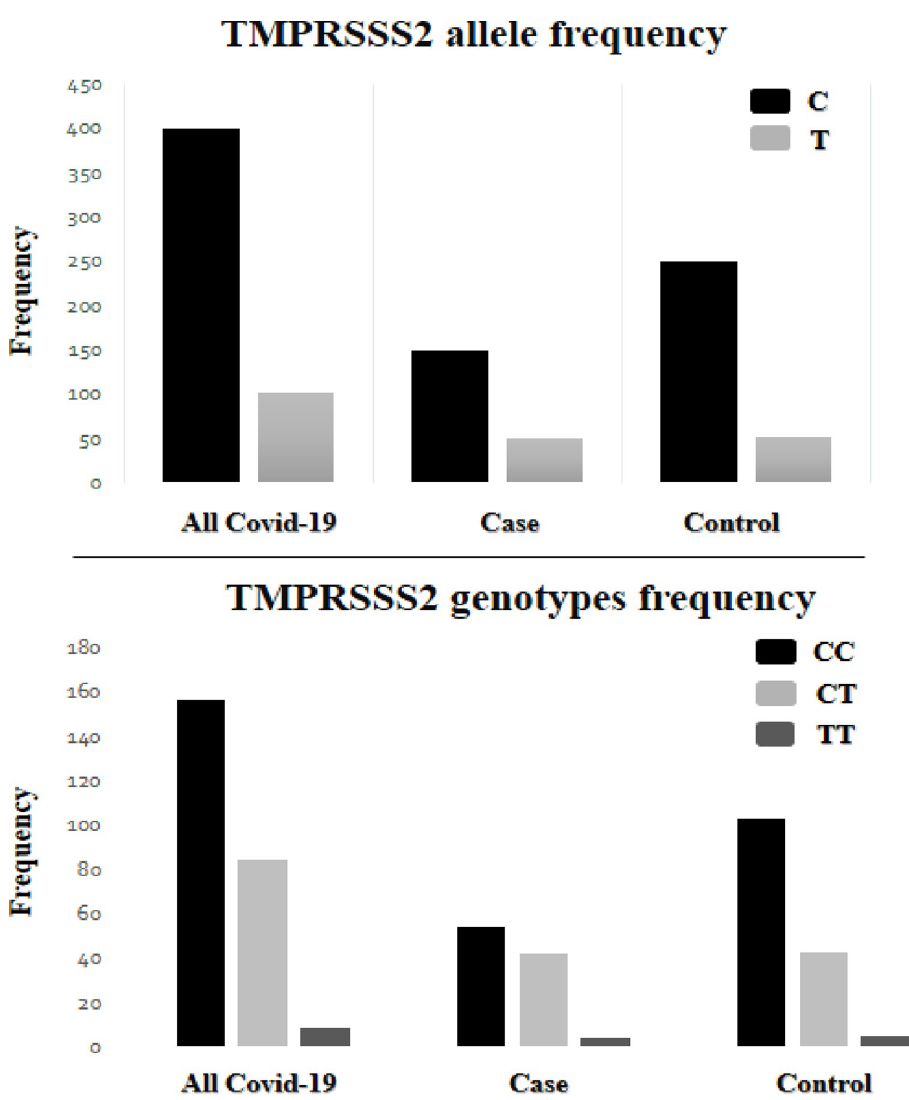
Fig 2. Allelic and genotypic frequency distributions of TMPRSS2 polymorphism in case and control groups and all COVID-19 patients (All COVID-19 patients = case +